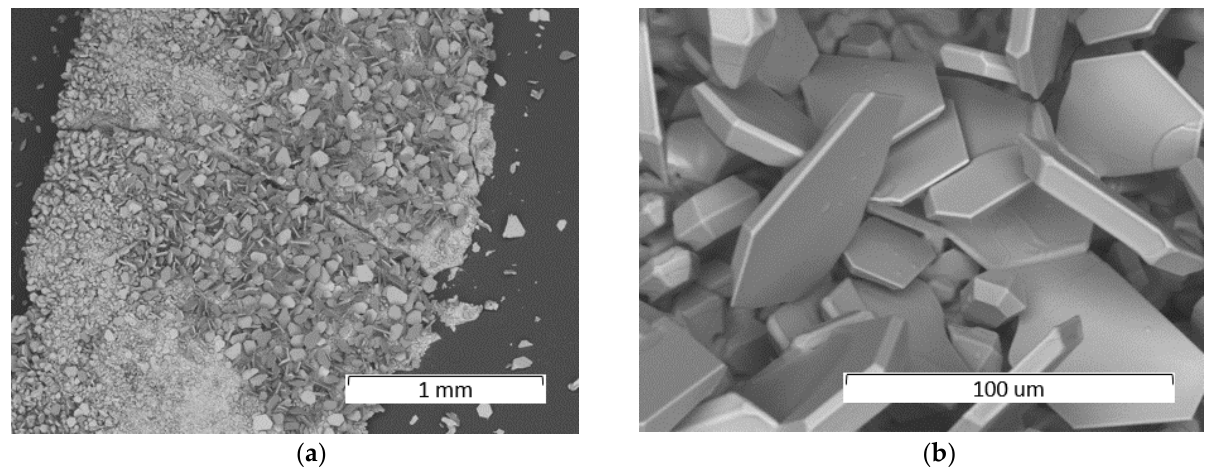
Figure 3. FTIR spectra of HA samples after sintering in a high-temperature furnace: (1) powder after 1000 °C during 2 h; (2) pellet after 1500 °C during 10 min; (3) pellet after 1500 °C during 2 h; (4) powder after 1500 °C during 10 min; (5) powder after 1500 °C during 2 h.